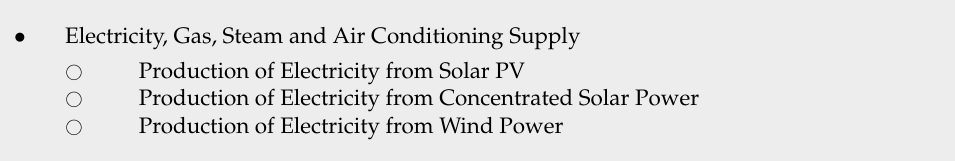
Table 2. Subset of the EU Sustainable Finance Taxonomy considered in this study.